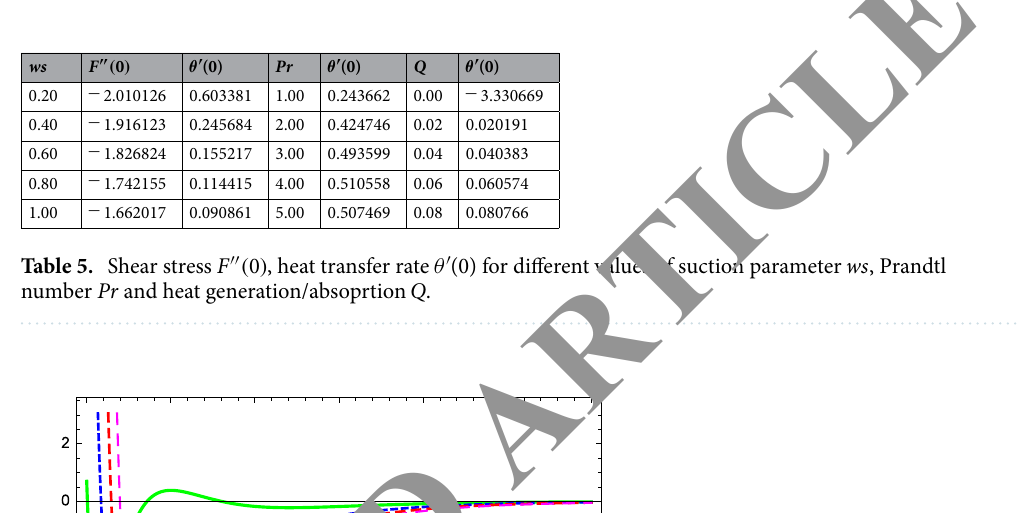
Figure 2. Effect of α on axial velocity B (ζ) .